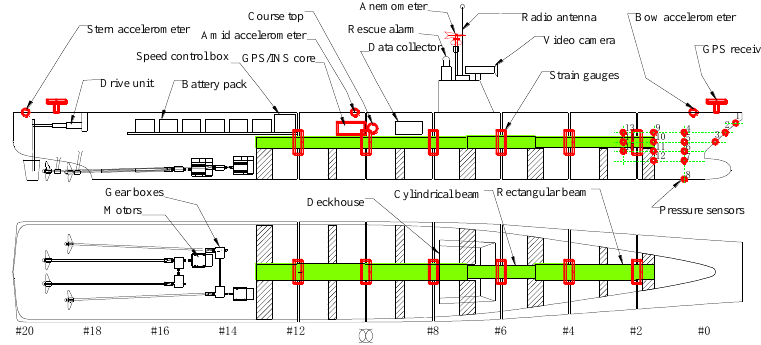
Figure 12. Conceptual design of the large-scale model arrangement.